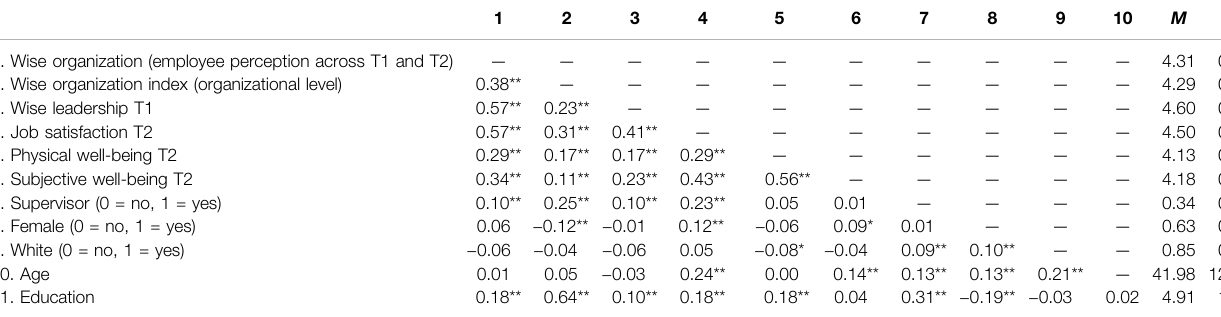
TABLE 4 | Bivariate Correlations; Pearson ’ s r .